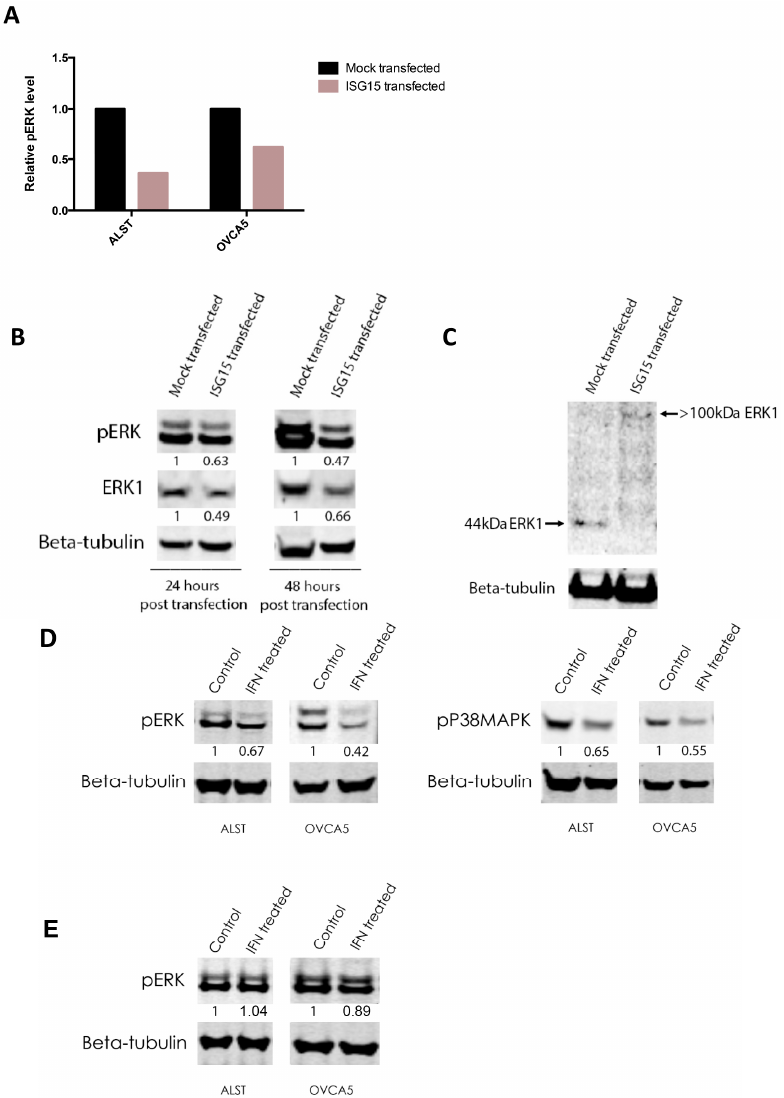
Figure 5. Endogenous ISG15 induced ISGylation of ERK1 and suppressed ERK1 activity. ( A ) Reverse phase protein array (RPPA) analysis showed that ALST and OVCA5 showed a 65% and 45%, respectively, decrease in the levels of Tyr204 phospho-p44 ERK1 when transfected with the full-length ISG15 expression construct when compared to mock. ( B ) Western blot analyses demonstrated a significant decrease in the levels of Tyr204 phospho-p44 ERK and total ERK1 expression in ISG15 transfected OVCA5 ovarian cancer cells when compared to mock transfected cells. (Numbers indicate band intensities relative to the corresponding control after normalization using intensities of housekeeping gene beta tubulin). ( C ) Western blot analysis detected the decrease in 44kDa ERK1 protein level and the presence of ISGylated ERK1 in ISG15 transfected OVCA5 cells. ( D ) Western blot analysis results showed that interferon gamma treated ALST and OVCA5 ovarian cancer cells had a significant decrease in phosphorylated ERK and P38MAPK protein levels when compared to control solvent treated cells. (Numbers indicate band intensities relative to the corresponding control after normalization using intensities of housekeeping gene beta tubulin). ( E ) Western blot analysis results showed that interferon gamma treatment on ISG15 silenced ALST and OVCA5 ovarian cancer cells had no effect on phosphorylated ERK protein levels when compared to control solvent treated cells. (Numbers indicate band intensities relative to the corresponding control after normalization using intensities of housekeeping gene beta